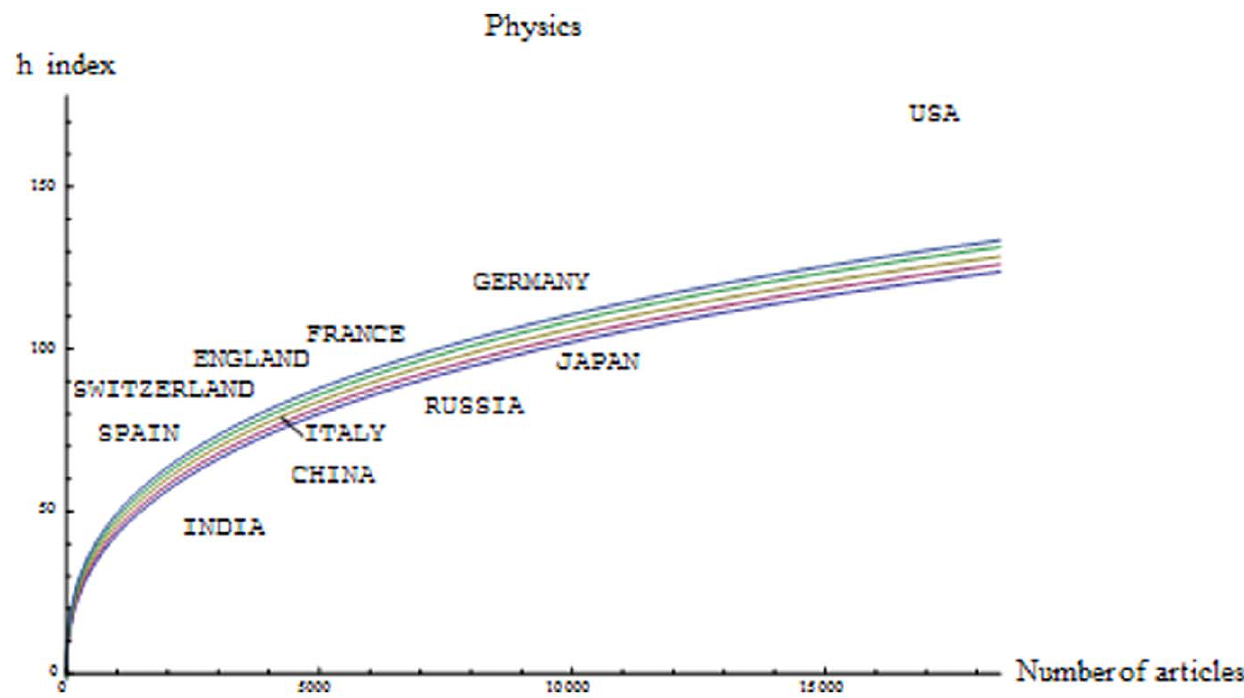
Figure 1. Field of Physics. Papers published in 1998. Curves represent for each number of articles the corresponding value of the h -index for which the merit is 10.00, 25.00, 50.00, 75.00 and 90.00 respectively. Points represent the number of papers and the values of the h -index for different countries.